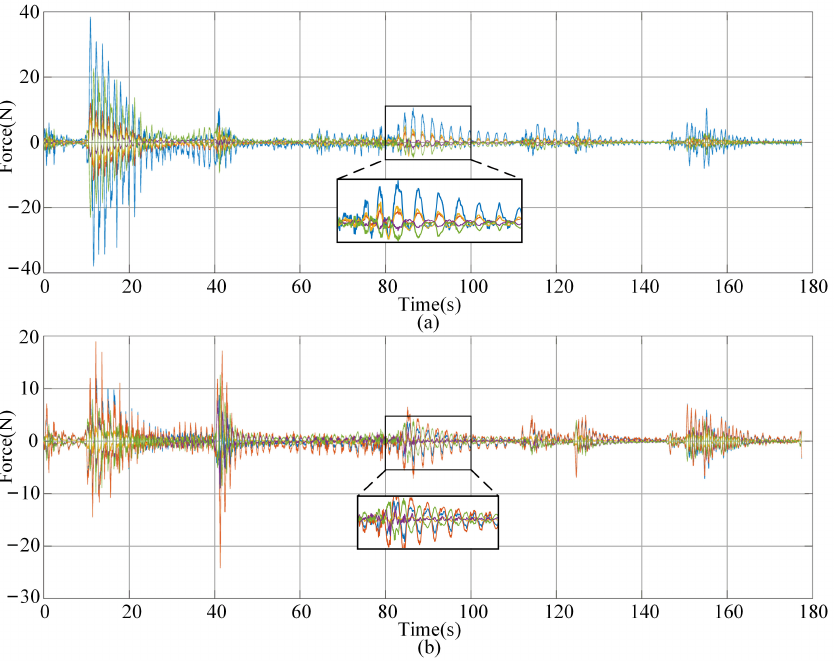
Figure 20. Tension curve of five linkage cables in the 3rd segment. ( a ) Alpha direction. ( b ) Beta direction.